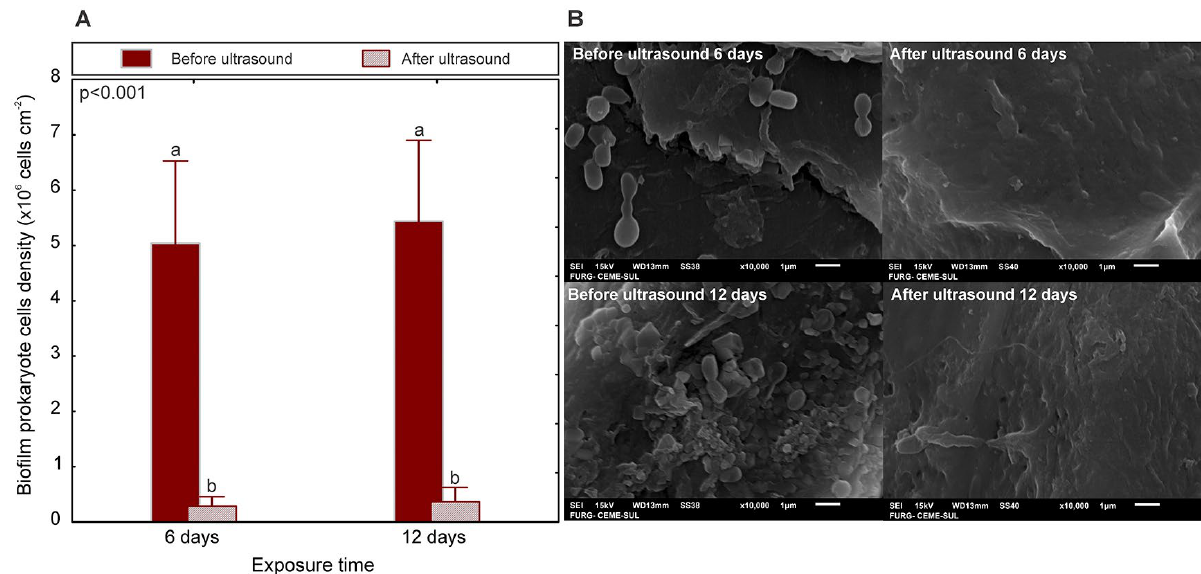
Fig. 2. – A: GLM results showing differences in biofilm prokaryote density (cells cm -2 ) before and after the ultrasound procedure at 6 and 12 days of exposure. The vertical lines denote confidence intervals (95%) (standard error*1.96). B: Scanning electron microscopy pictures show differences in the prokaryote density on marine-grade plywood surface at 6 and 12 days of exposure before and after the ultrasound procedure. Lowercase letters indicate similarities (p>0.05) or statistical differences (p<0.05) in prokaryote cell quantification between stains, and capital letters indicate statistical similarities (p>0.05) or differences (p<0.05) in detritus quantification between